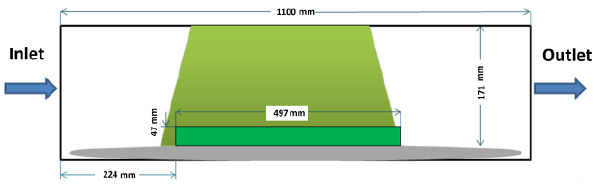
Fig. 1. The scheme of the obstacle position on the underlying surface with smooth wing edge in the working section of wind tunnel (lighting scheme corresponding the measurements of the overall flow picture).